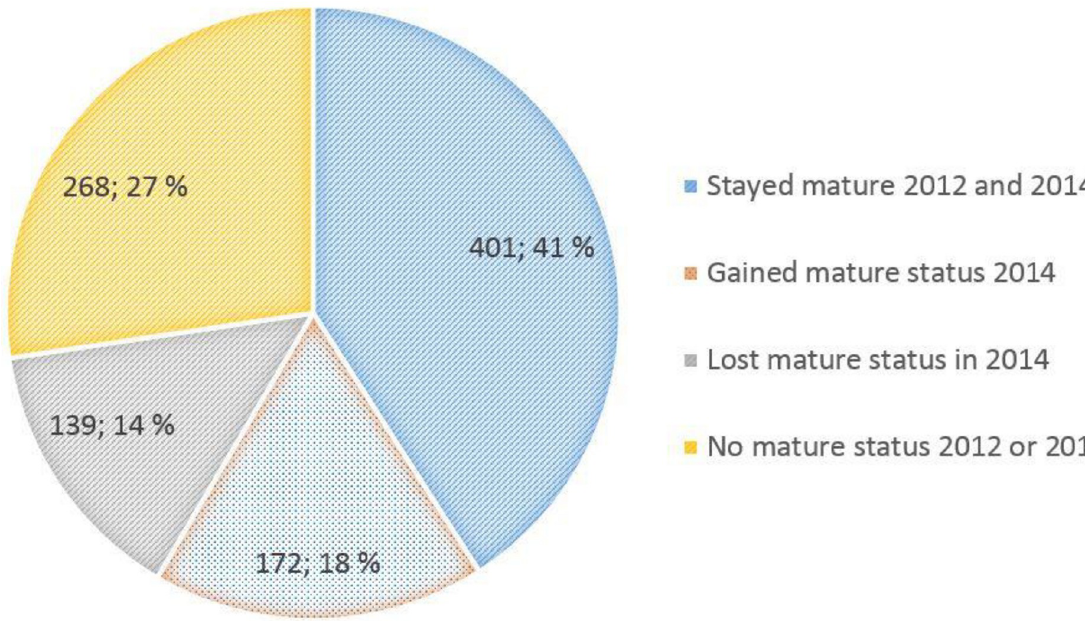
Fig 1. Units that changed their level of mature safety climate between 2012 and 2014, by number of units and percentage.